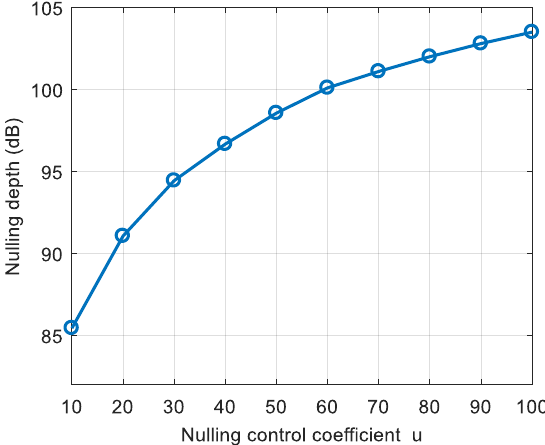
Figure 21. The corresponding nulling depths for different nulling control coefficients.